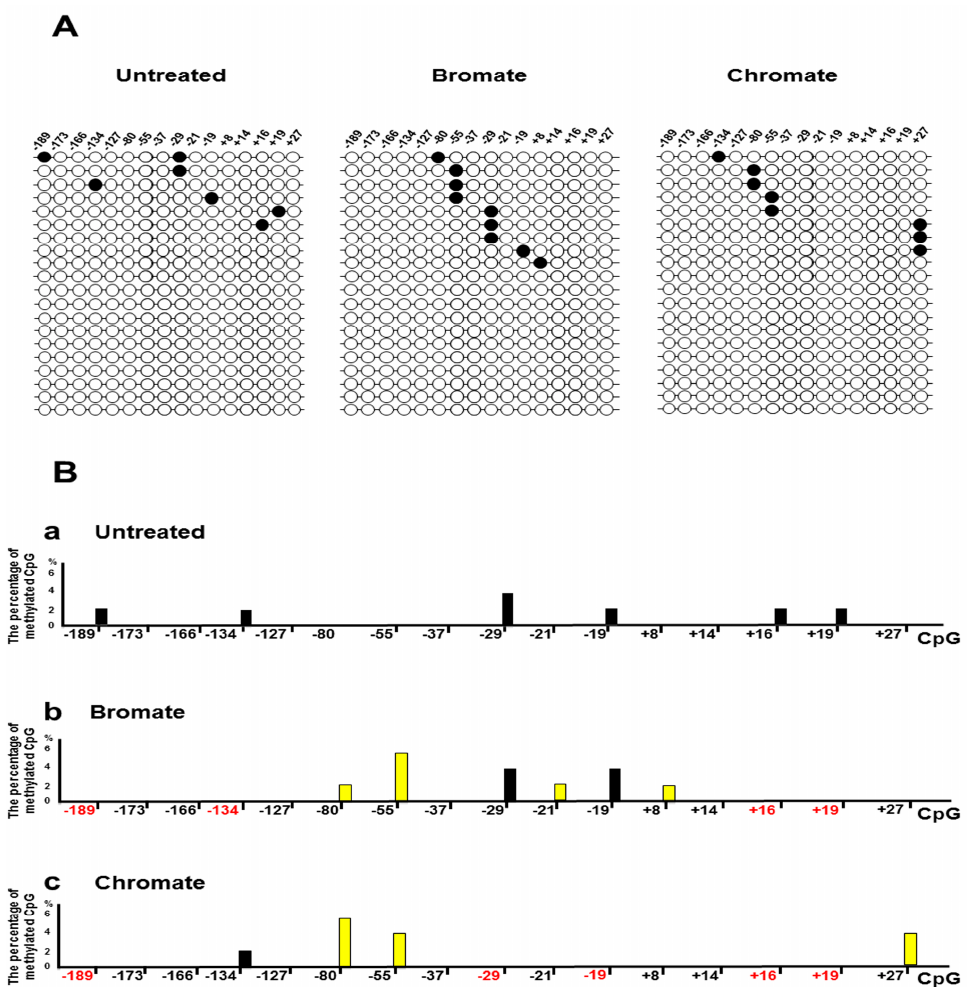
Figure 1. Oxidative DNA damage modulates the DNA methylation pattern of the promoter and transcribed regions of the breast cancer 1 (BRCA1) gene in cells: HEK293H cells were treated with bromate or chromate, as described in the Materials and Methods section. Subsequently, genomic DNA was isolated from the cells and subject to bisulfite sequencing. ( A ) Representative results of the DNA methylation pattern of the BRCA1 promoter and transcribed regions ( − 189 to + 27) are illustrated. The panel on the left indicates the results of the untreated cells. The panel in the middle represents the results from the cells treated with 5 mM bromate for 24 h with recovery for 48 h. The panel on the right illustrates the results from the cells treated with 10 µ M chromate for 24 h with recovery for 48 h. ( B ) The percentage of methylated CpGs: Panels a, b, and c illustrate the percentage of methylated CpGs in the promoter and transcribed regions of BRCA1 gene in the untreated cells, cells treated with 5 mM bromate for 24 h with 48 h recovery, and cells treated with 10 µ M chromate for 24 h with 48 h recovery, respectively. The bars in yellow indicate the new DNA methylation sites induced by bromate or chromate. The percentage of methylated CpGs was calculated from the DNA sequencing results from at least 50 colonies.